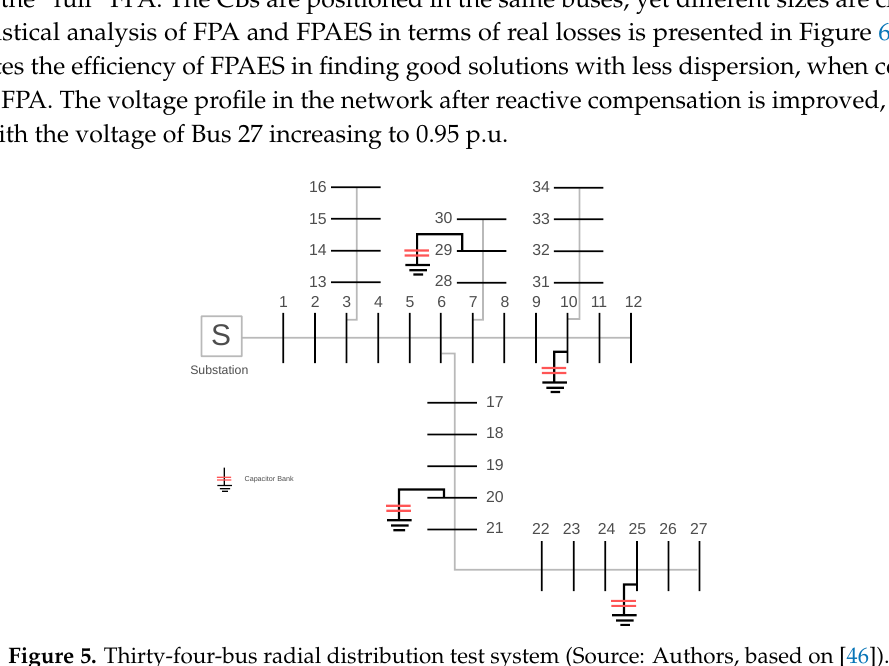
Figure 5. Thirty-four-bus radial distribution test system (Source: Authors, based on